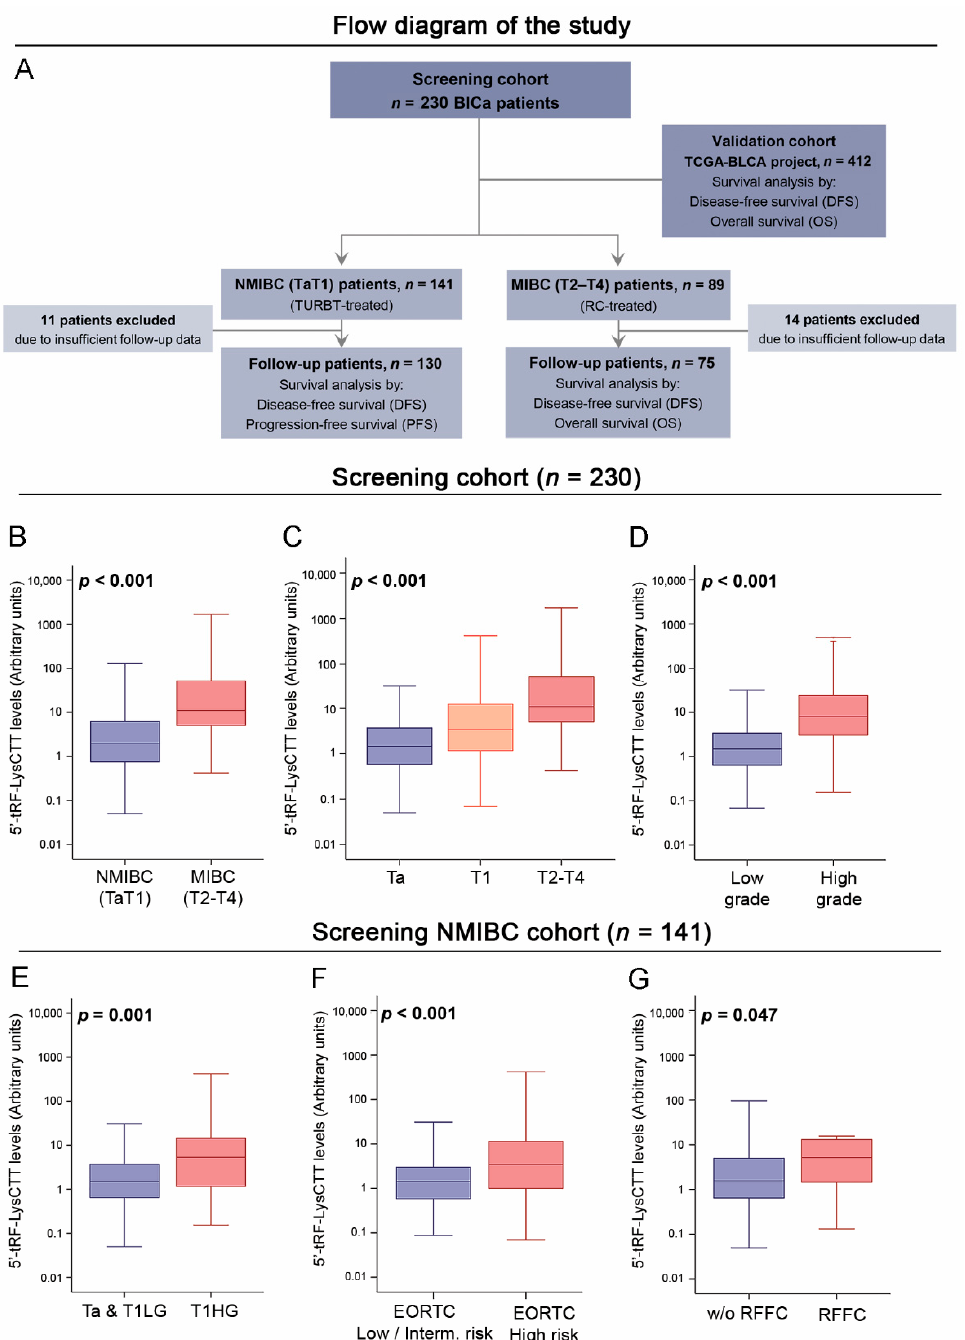
Figure 3. Analysis of 5 (cid:48) -tRF-LysCTT in bladder tumors. ( A ) Flow diagram of the study. ( B – D ) Box plots presenting the correlation of 5 (cid:48) -tRF-LysCTT levels with non-muscle invasive (NMIBC) and muscle-invasive (MIBC) bladder cancer ( B ), tumor stage ( C ) and tumor grade ( D ) in the screening cohort (n = 230). p -values calculated by Mann–Whitney U test ( B , D ) and Kruskal–Wallis test ( C ). ( E – G ) Box plots presenting the correlation of 5 (cid:48) -tRF-LysCTT levels with tumor stage and grade ( E ), EORTC risk-group ( F ) and recurrence at first follow-up cystoscopy (RFFC) in the screening NMIBC cohort (n = 141). p -values calculated by Mann–Whitney U test ( E – G